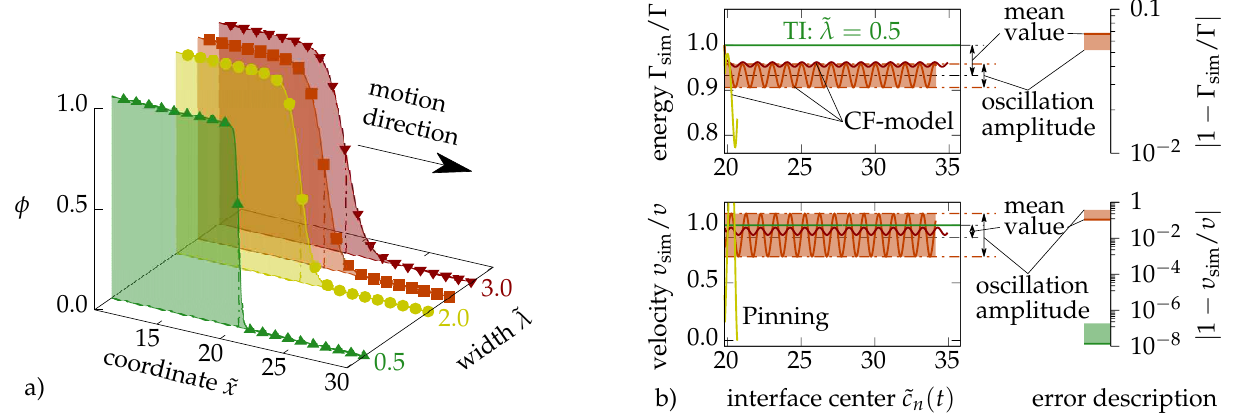
Figure 1. Illustration of the influence of spurious grid friction on the motion of a constantly driven, planar interface. ( a ) Comparison of conventional continuum field (CF) models for different phase- field profile resolutions ˜ λ = λ / ∆ x with the translational invariant (TI) model for ˜ λ = 0.5 (green curves) ( b ) The energy density and the interface velocity, as measured during the simulation, are plotted as functions of the advancing interface center ˜ c n ( t ) = c n ( t ) / ∆ x . The dimensionless driving force is ˜ µ = µ ∆ x / Γ = 0.1. The CF model is subject to pinning for the case of ˜ λ = 2.0. The logarithmic scale bar on the right shows how much smaller the relative velocity error for the TI model is in comparison to those from the CF model. An animated version of this figure is provided in the Supplementary